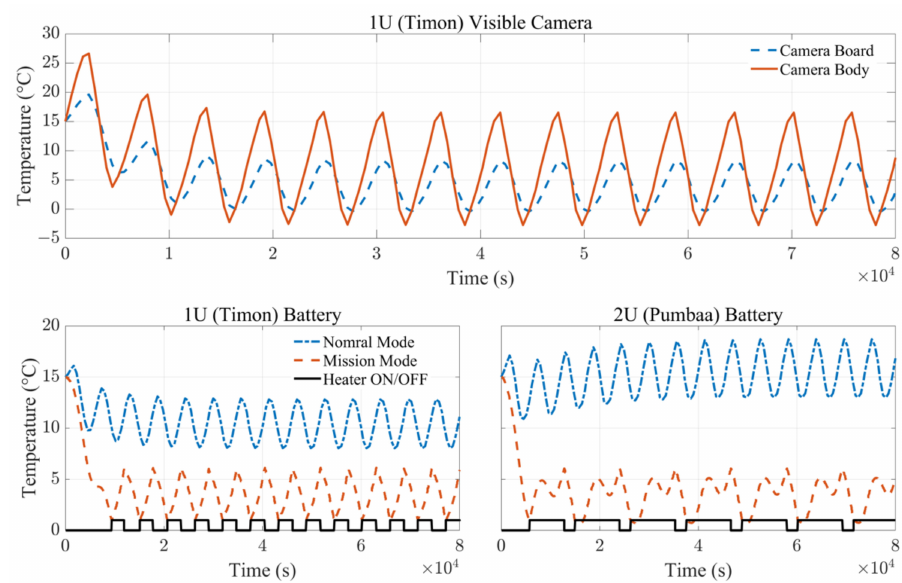
Figure 11. Temperature of visible camera and battery and operation of battery heater.